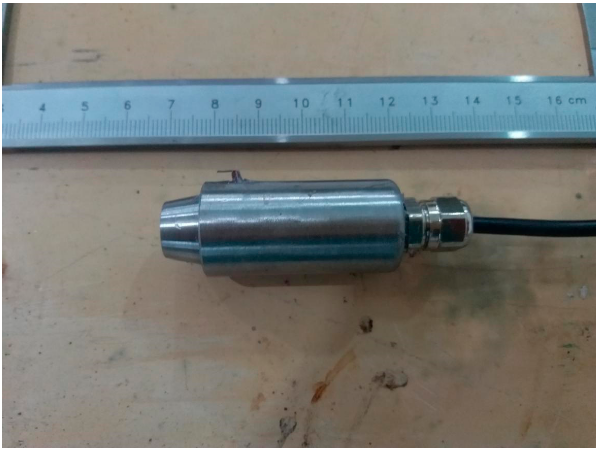
Figure 11. A picture of the finished sensor probe.